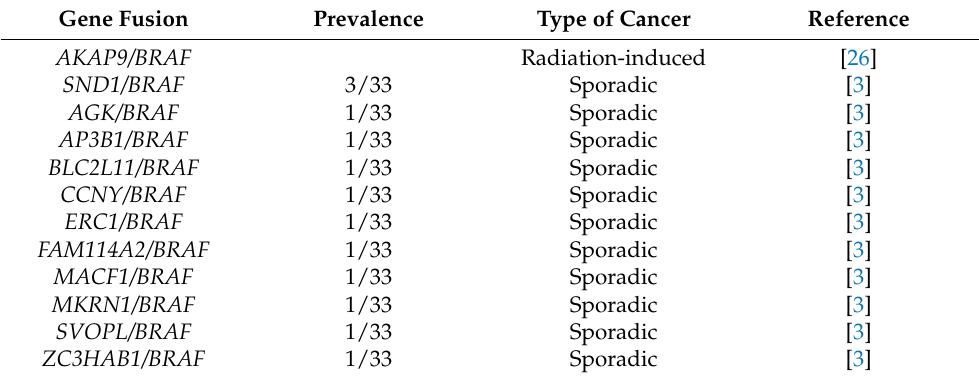
Table 1. BRAF rearrangements in thyroid